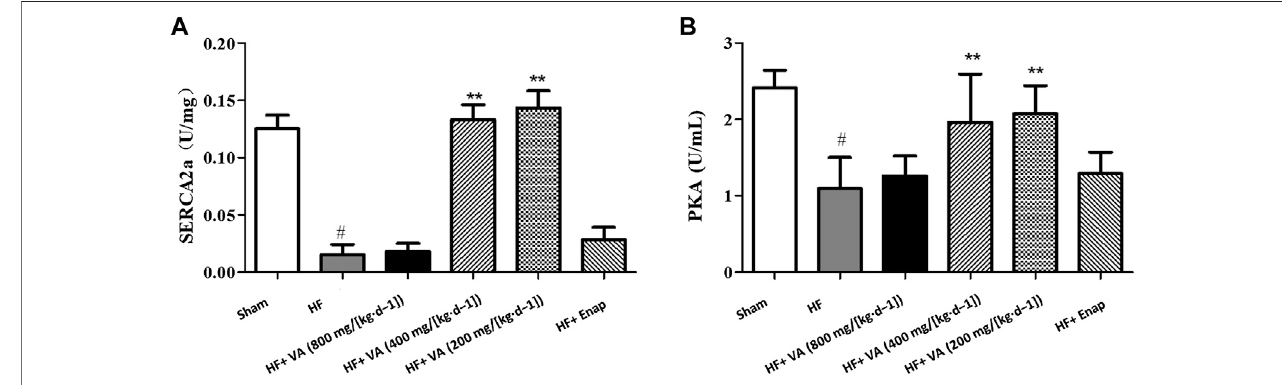
FIGURE 7 | The effectof velvet antlers (VA) on SERCA2a (A) and PKA (B) activity. The data are expressed as means ± SEM. #: p < 0.01 vs. the sham group; *: p < 0.05 vs. the heart failure (HF) group; **: p < 0.01 vs. the HF group. n (cid:1) 6. Enap: enalapril.